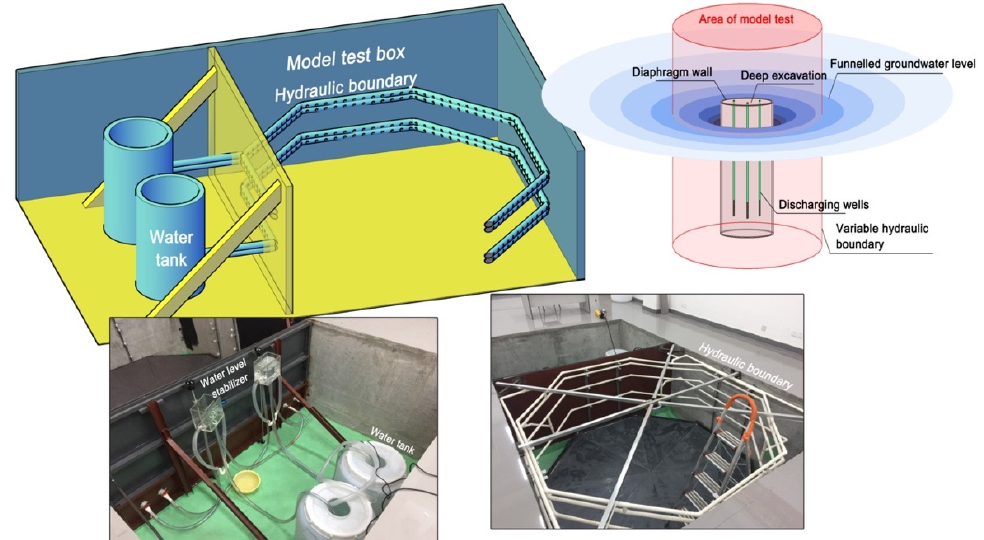
Figure 2. Structure of model test box with artificial assumption boundary.